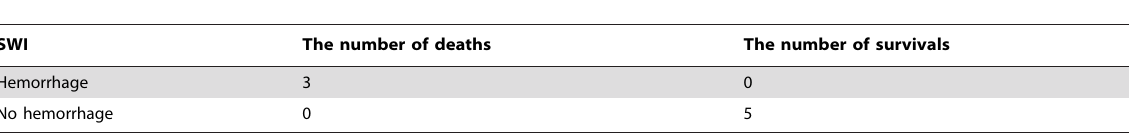
Table 3. Statistical data of 8 patients with heat stroke according to SWI and prognosis.